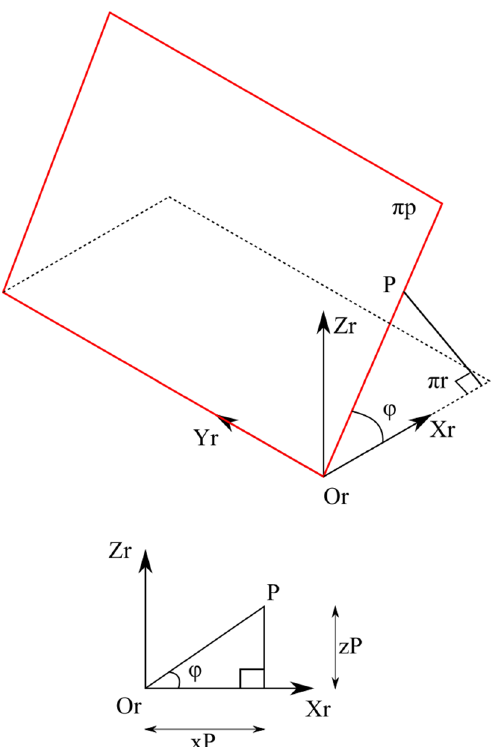
Figure 7. Support for determining the equations for π r and π p.